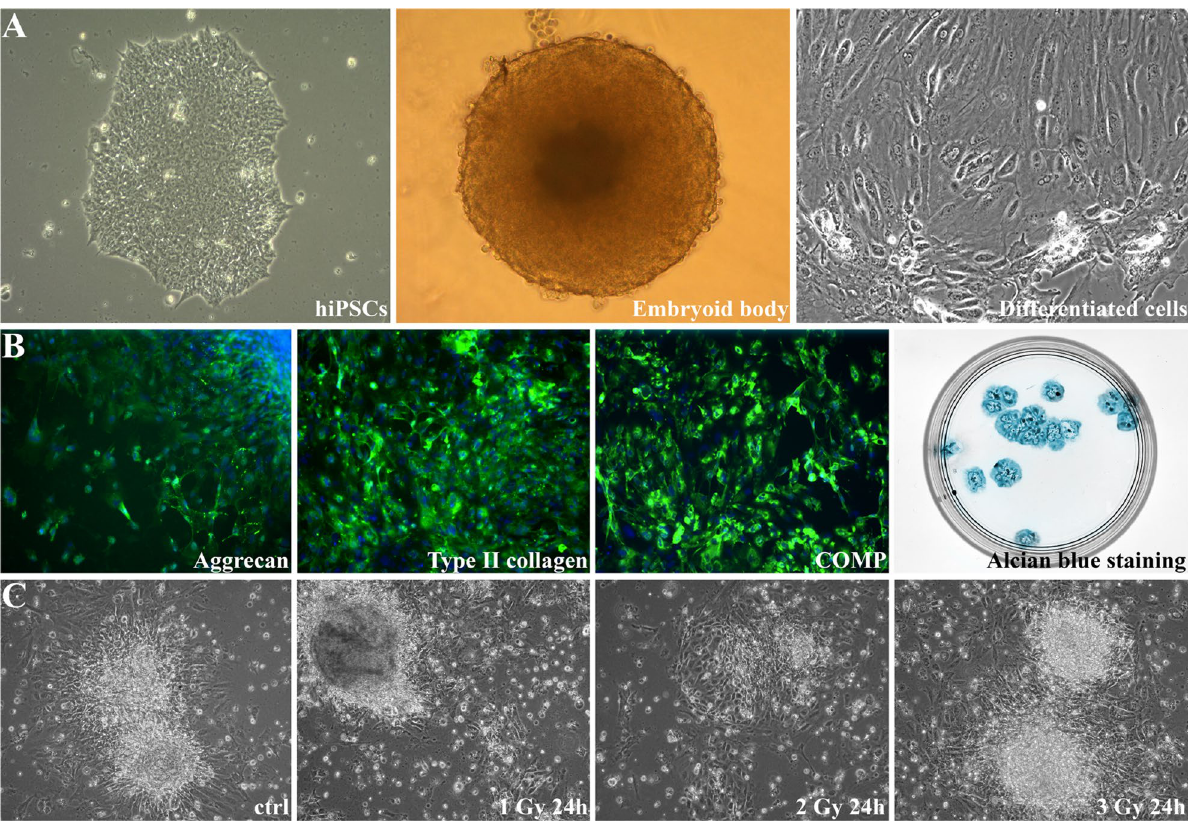
Figure 1. Human-induced pluripotent stem cells (hiPSCs) underwent chondrogenic differentiation in a medium supplemented with TGF-β3 via EBs ( A ). The obtained chondrocyte-like cells revealed markers characteristic of chondrocytes, including aggrecan, type II collagen, cartilage-oligomeric matrix protein (COMP), and proteoglycans visualized by alcian blue staining ( B ). Those cells were treated with ionizing radiation at 1, 2 and 3 Gy ( C